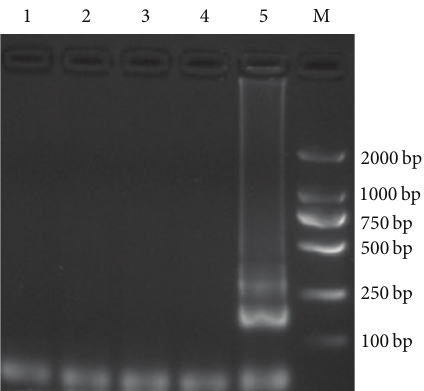
Figure 3: Specificity of the LAMP assay. 1: negative control; 2: GSIV; 3: AngHV-1; 4: KHV; 5: CyHV-2; M: DL2000 DNA marker.